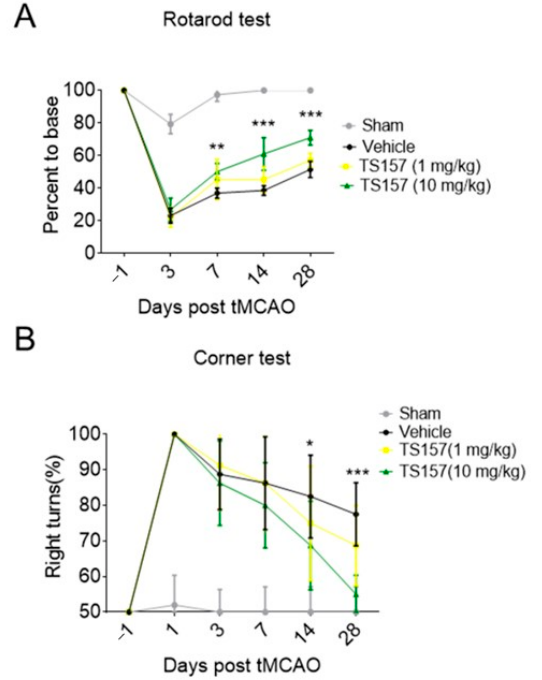
Figure 5. TS-157 significantly improves the exercise ability and movement perception of tMCAO rats. ( A ) Rotarod test for tMCAO rats in sham groups, control group, low-dose group (TS-157, 1 mg/kg), and high-dose group (TS-157, 10 mg/kg); ( B ) corner test for tMCAO rats in above groups. Data obtained from the 8–10 mice per group are expressed as mean ± SEM. Statistically significant differences: * p < 0.05, ** p < 0.01, *** p < 0.001 vs. vehicle (two-way ANOVA followed by Bonferroni test).